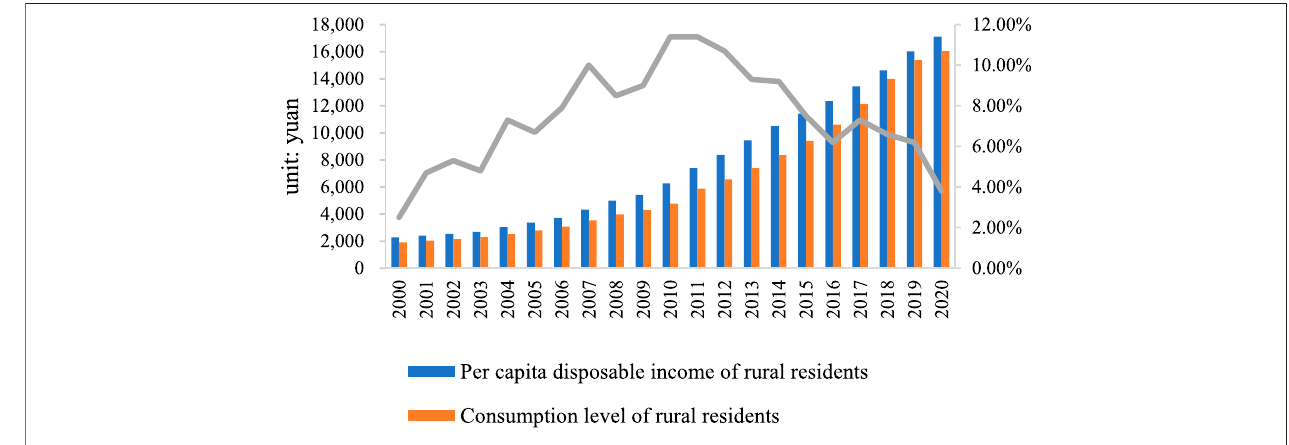
FIGURE 2 | Per capita disposable income and consumption of rural residents in China from 2000 to 2020 (Data source: National Bureau of Statistics of China).